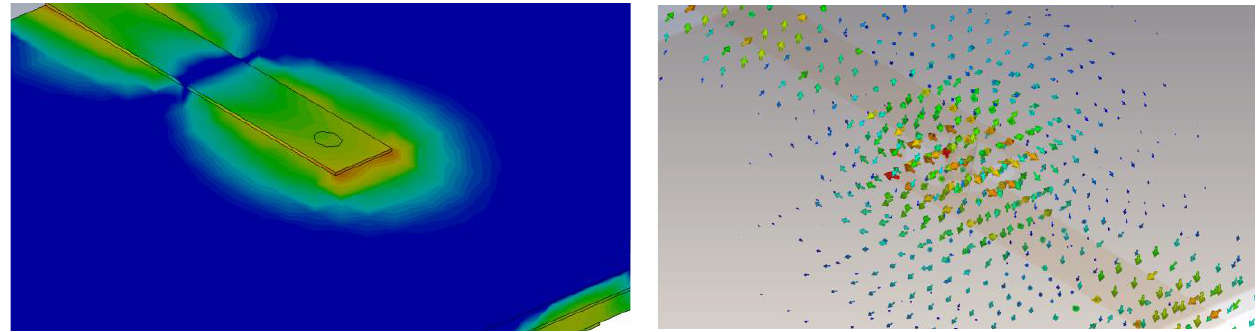
Figure 13. E-field indication through via-hole pin current density.